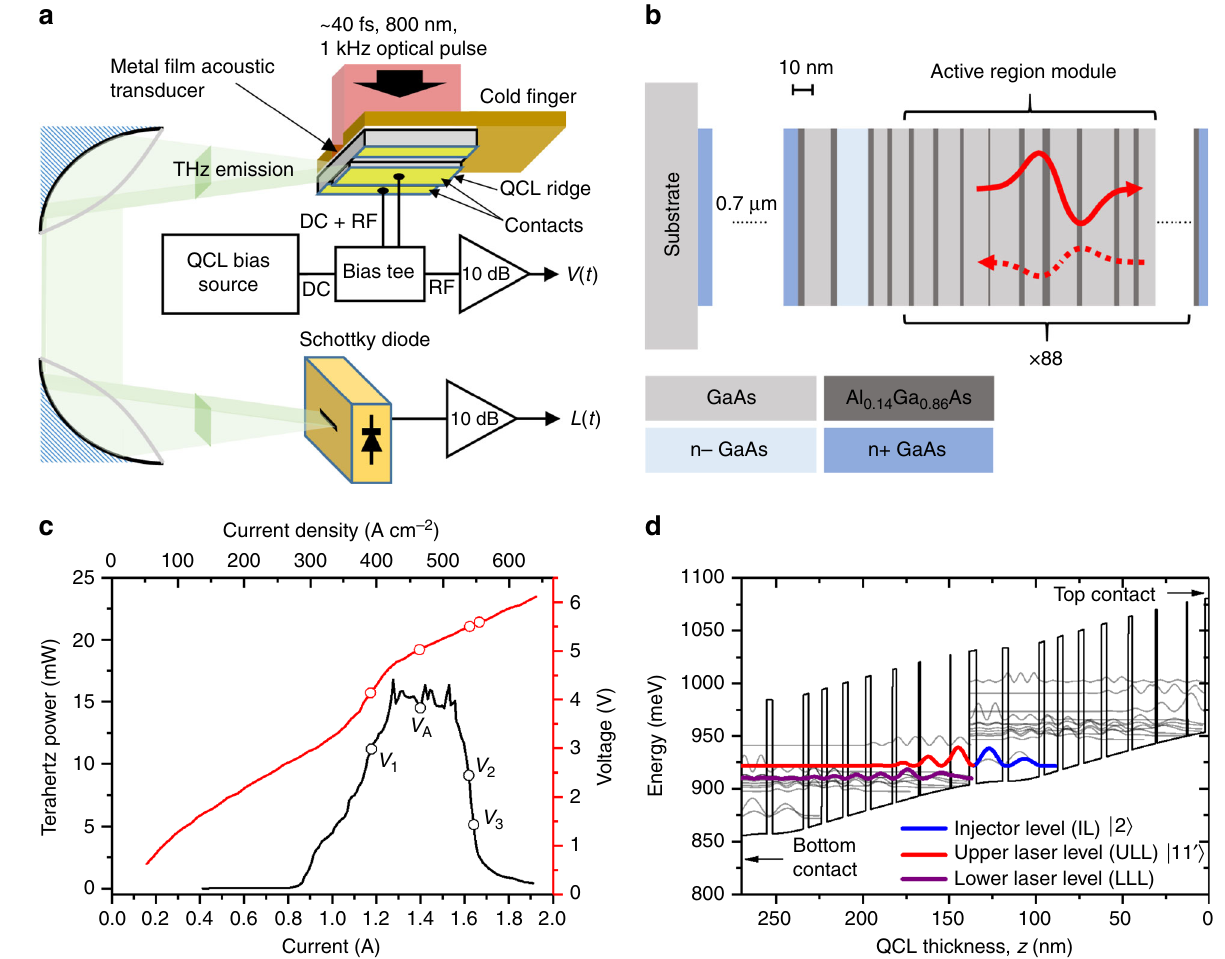
Fig. 1 Experimental arrangement and QCL device structure and characteristics. a Experimental arrangement for measuring the optical and electronic perturbation of a THz QCL by laser-generated picosecond acoustic pulses. The sample is mounted on the cold fi nger of an optical cryostat at an operating temperature of 15 K. b Schematic diagram of the QCL device structure showing the transmitted (solid red line) and re fl ected (dashed red line) strain pulses. c L ‒ I ‒ V characteristics of the QCL in the absence of acoustic pulses, measured at a temperature of ~10 K and driven with 50- µ s pulses at a 1-kHz repetition rate. Labels correspond to the different QCL biasing conditions used in experiments: ( V 1 = 4.13 V, V A = 5.02 V, V 2 = 5.49 V and V 3 = 5.58 V). d Simpli fi ed QCL band structure showing two periods of the structure with labelled injection level (IL-|2 〉 ), upper laser level (ULL-|11 ′ 〉 ) and lower lasing level (LLL). Source data for c and d are provided in ref. 50